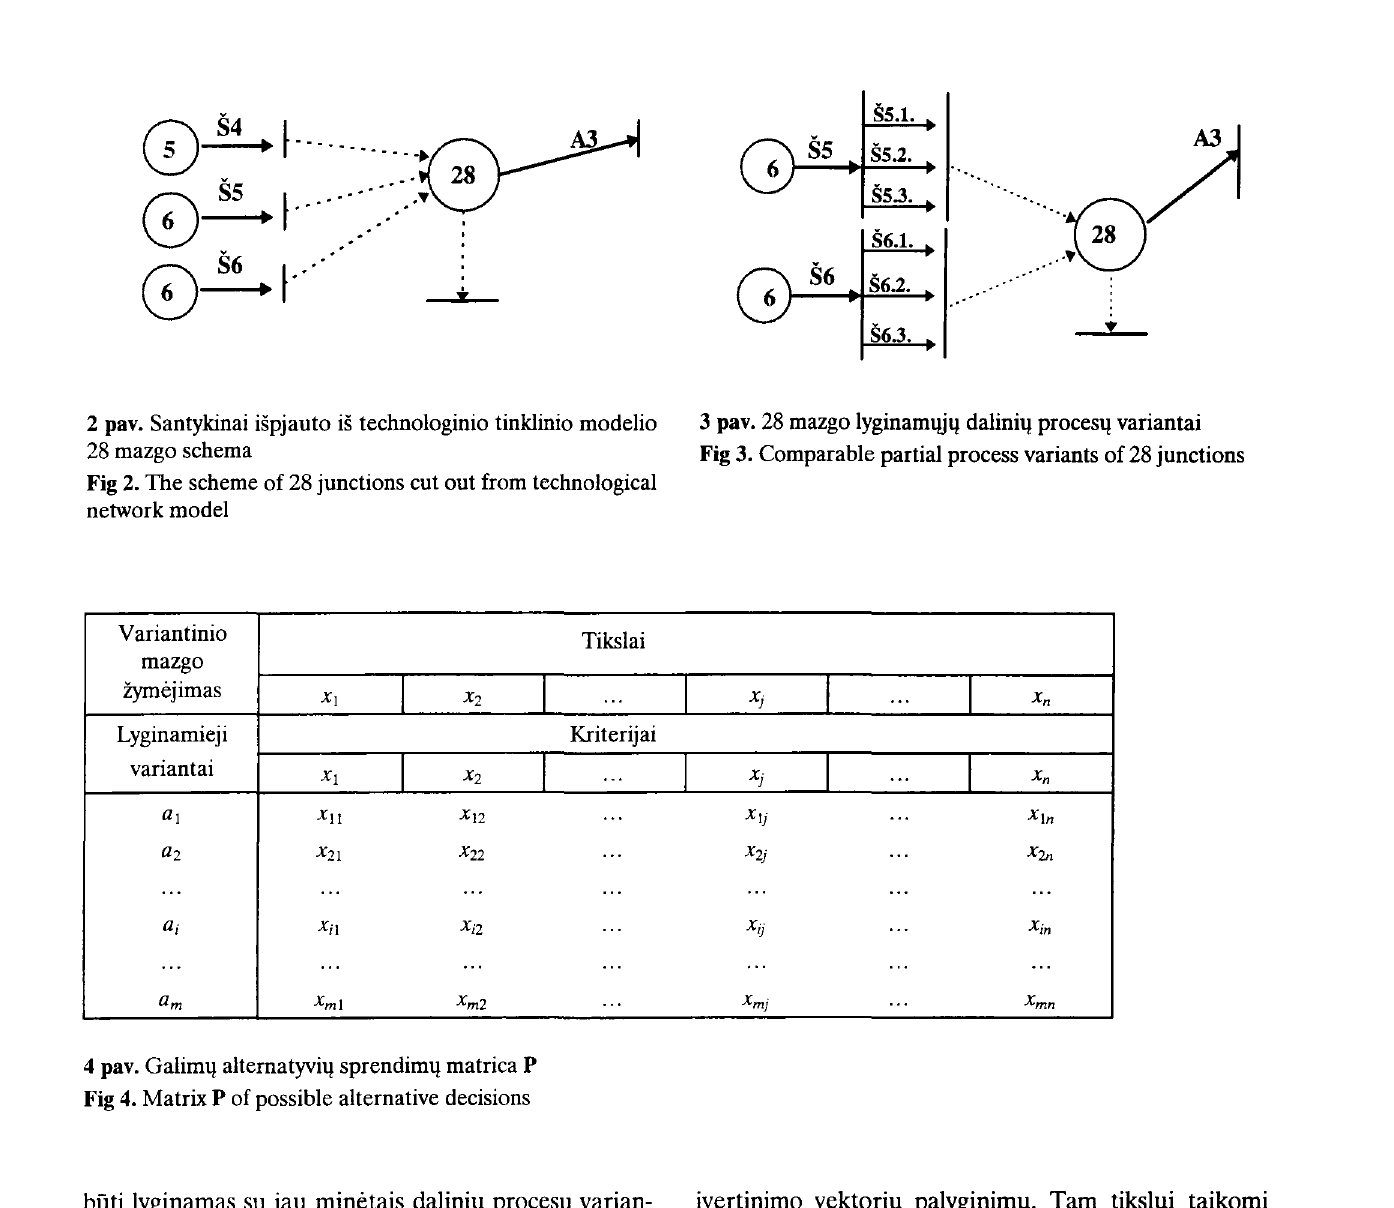
Fig 3. Comparable partial process variants of 28